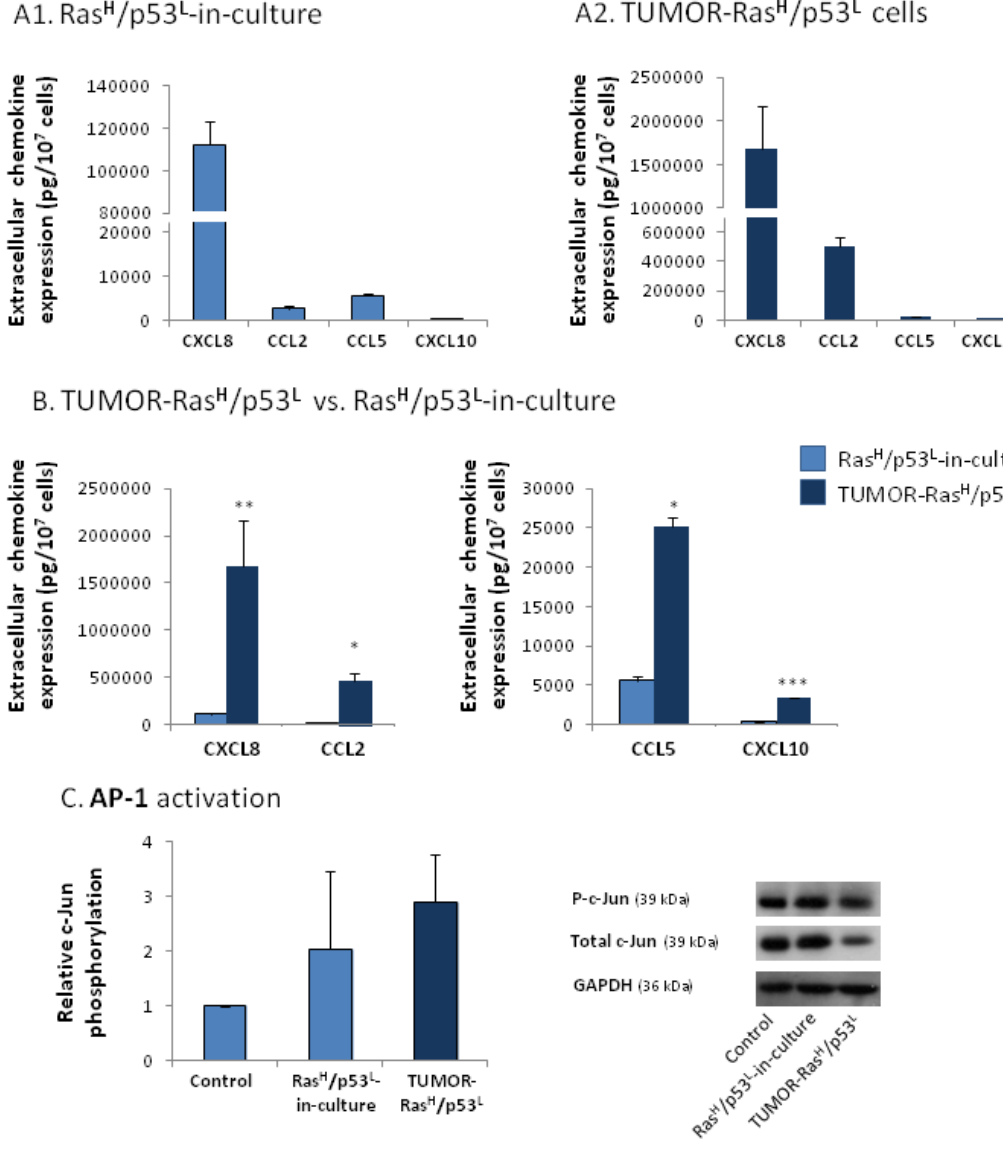
Figure 4. Exposure to the host microenvironment promotes the release of the cancer-related chemokine cluster, possibly through inflammation-related stimuli. ( A , B ) Chemokine expression was determined in supernatants of the cells by sandwich ELISA assays, at the linear range of absorbance. ( A1 ) General relative pattern of chemokine release by Ras H /p53 L -in-culture cells expressing oncogenic Ras and knocked-down p53. ( A2 ) General relative pattern of chemokine release by TUMOR-Ras H /p53 L cells that were obtained by inoculation of Ras H /p53 L -in-culture cells to mice. ( B ) Comparison between the levels of chemokines released by Ras H /p53 L -in-culture cells and TUMOR-Ras H /p53 L cells. * p < 0.05, ** p < 0.01, *** p < 0.002 for differences between the two cell types. In parts ( A ) and ( B ), the results are representatives of at least n = 3. ( C ) C-Jun activation in TUMOR-Ras H /p53 L cells, in Ras H /p53 L -in-culture cells and in control cells, in which the expression of Ras and p53 was not modified, determined by Western blot analysis. Relative c-Jun phosphorylation levels were calculated as described in the “Experimental Section”. The results are an average ± SD of n =